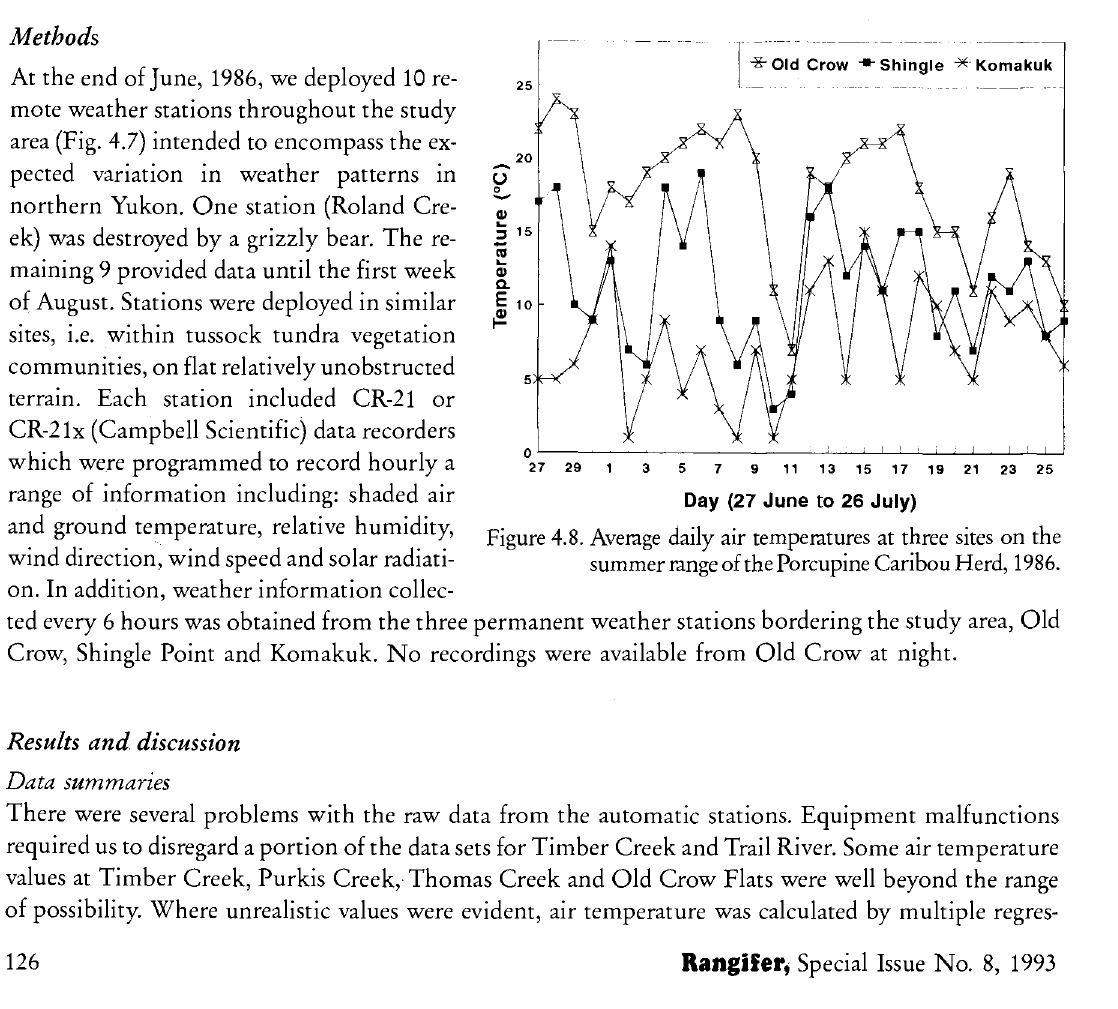
Figure 4.8. Average daily air temperatures at three sites on the summer range of the Porcupine Caribou Herd,